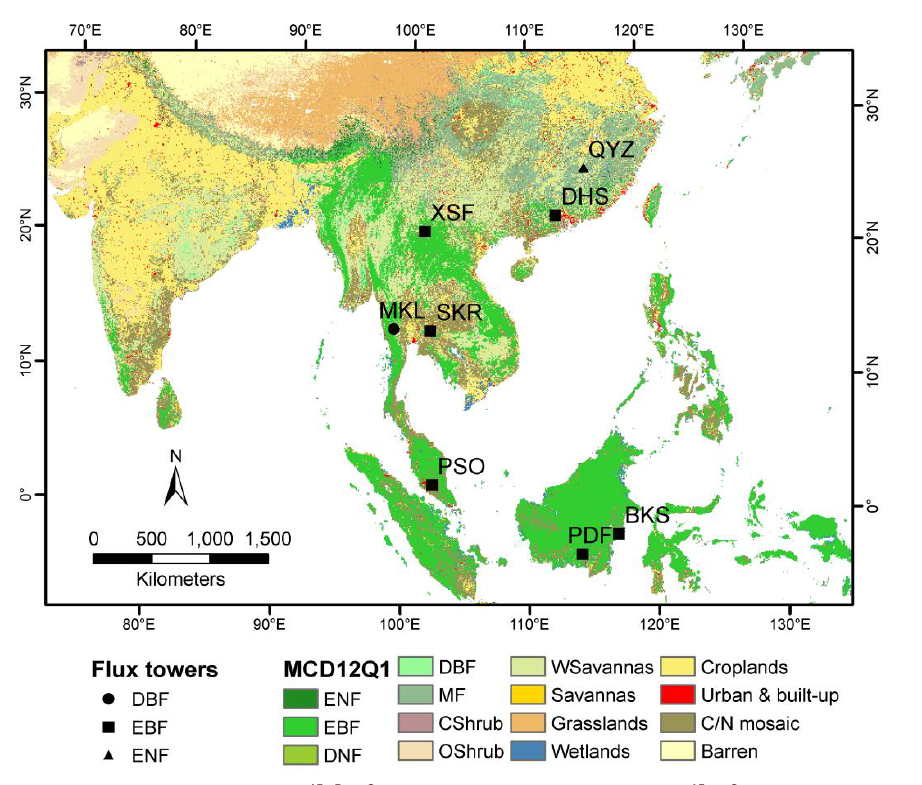
Figure 2. The vegetation classification map according to the MODIS land cover product (MOD12Q1). The locations of the flux tower sites used to assess the remote sensing based FPAR and GPP in this study are also shown as symbols. More detailed descriptions of the eight sites are given in Table